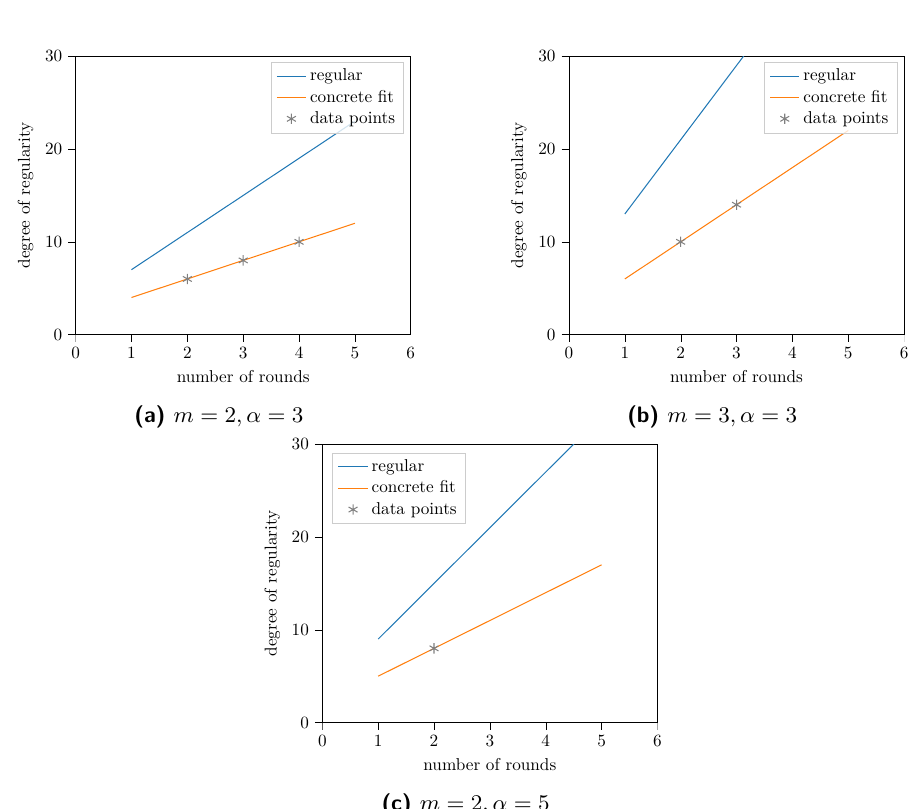
Figure 3: Concrete degree of regularity for instances of Rescue (blue) compared to the expected degree of regularity for a random polynomial system of the same number of equations and variables (orange). In all cases, the experimental data fits 0 . 5( α − 1) mN + 2 suggesting a concrete-to-regular degree ratio d reg ≤ d con 2